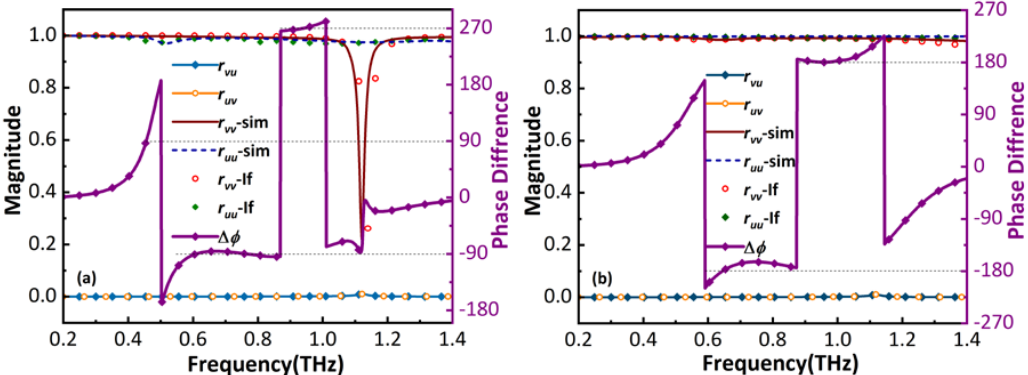
Figure 8. The calculated and simulated reflection coefficients of u- and v-polarized reflected waves. ( a ) LTC polarization conversion, ( b ) Cross-polarization conversion.